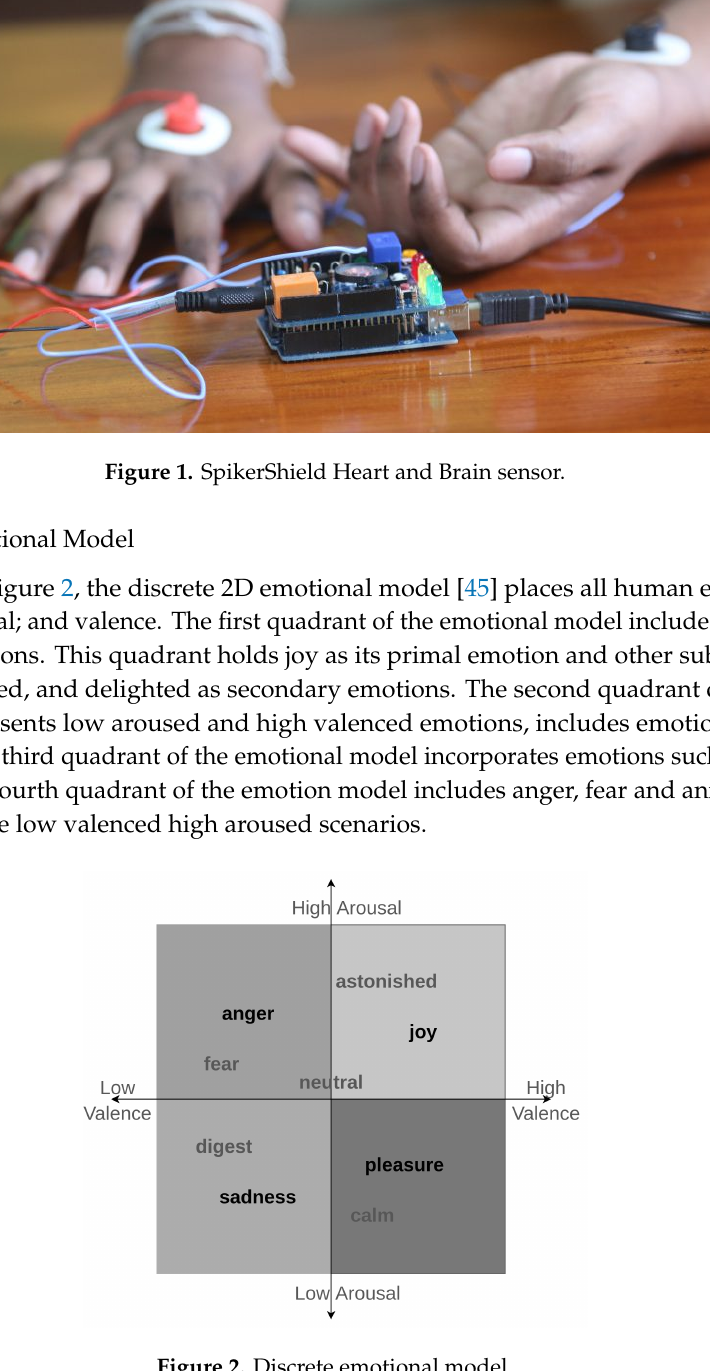
Figure 2. Discrete emotional